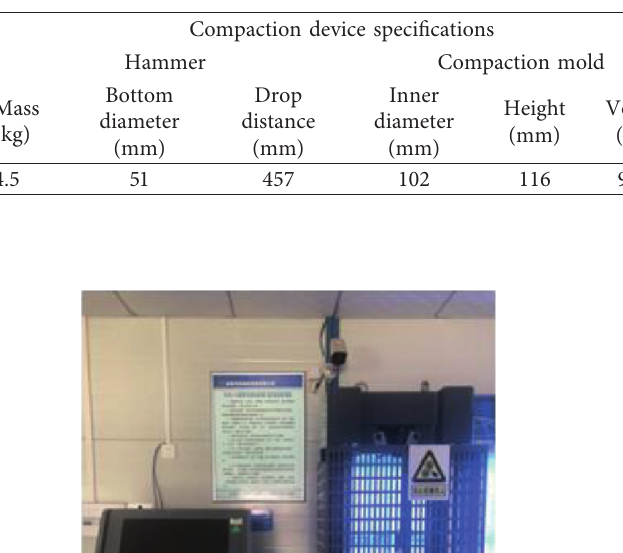
Table 4: The standard technical parameters of heavy compaction test (HCT-Z1).